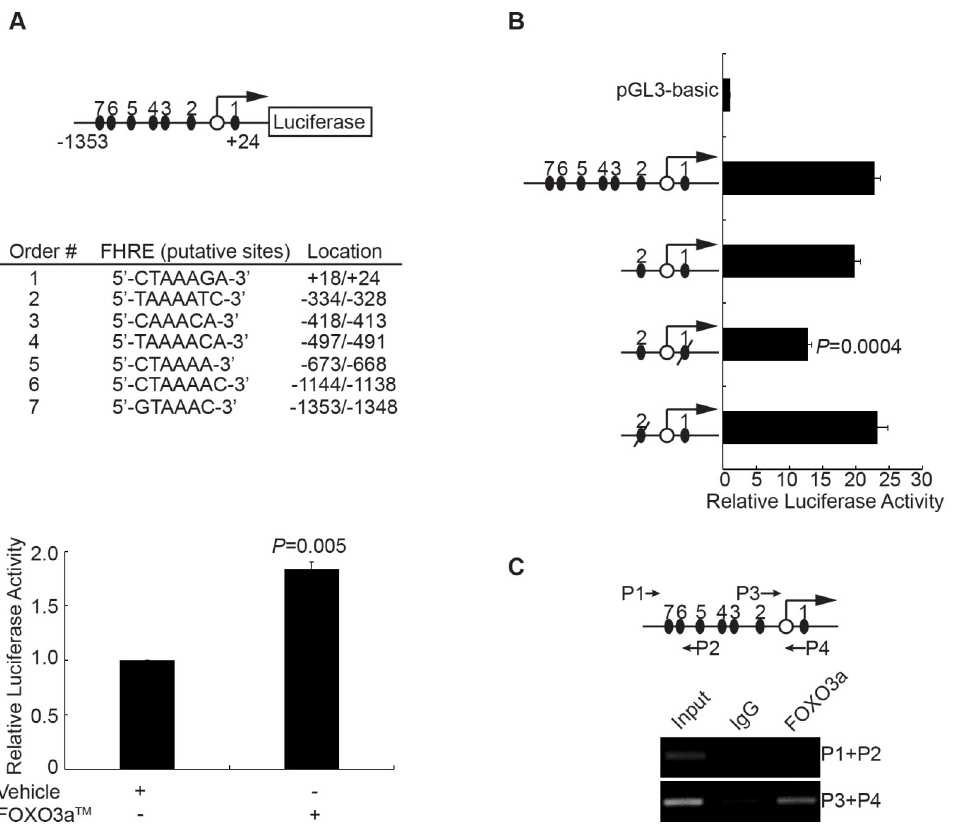
Figure 4. PLZF is a direct target gene of FOXO3a. A. The luciferase reporter plasmid pGL3-PLZF, shown in the top and middle panel, is driven by seven putative FHREs in PLZF promoter. In the top diagram, black ovals and the empty circle represent the putative FHREs and the transcriptional start site, respectively. PC3 cells were transfected with 100 ng of pGL3-PLZF and/or 200 ng of FOXO3a TM together with pSV40-renilla for 24 hours. The folds of the relative pSV40-Renilla-normalized FHREs-Luc activity against cells without FOXO3a TM were calculated, shown as the means with bar as SD from three independent experiments. The P values for comparison were gotten by Student’s t -test. B. PC3 cells were transfected with pGL3- PLZF or its truncations or empty vector pGL3-basic as indicated in the presence of FOXO3a TM expressing vector for 24 hours. The folds of the relative pSV40-Renilla-normalized FHREs-Luc activity against cells with empty vector pGL3-basic were calculated, shown as the means with bar as SD from three independent experiments. The P values for comparison were gotten by Student’s t -test. C. PC3 cells were cross-linked and lysed, followed by immunoprecipitating with anti-FOXO3a antibody or non-specific IgG. Precipitated DNAs and total lysis were amplified by PCR with primers for district between FHRE1 and FHRE2 or district between FHRE6 and FHRE7, as shown in the top panel. The ChIP assay was repeated individually for three times.